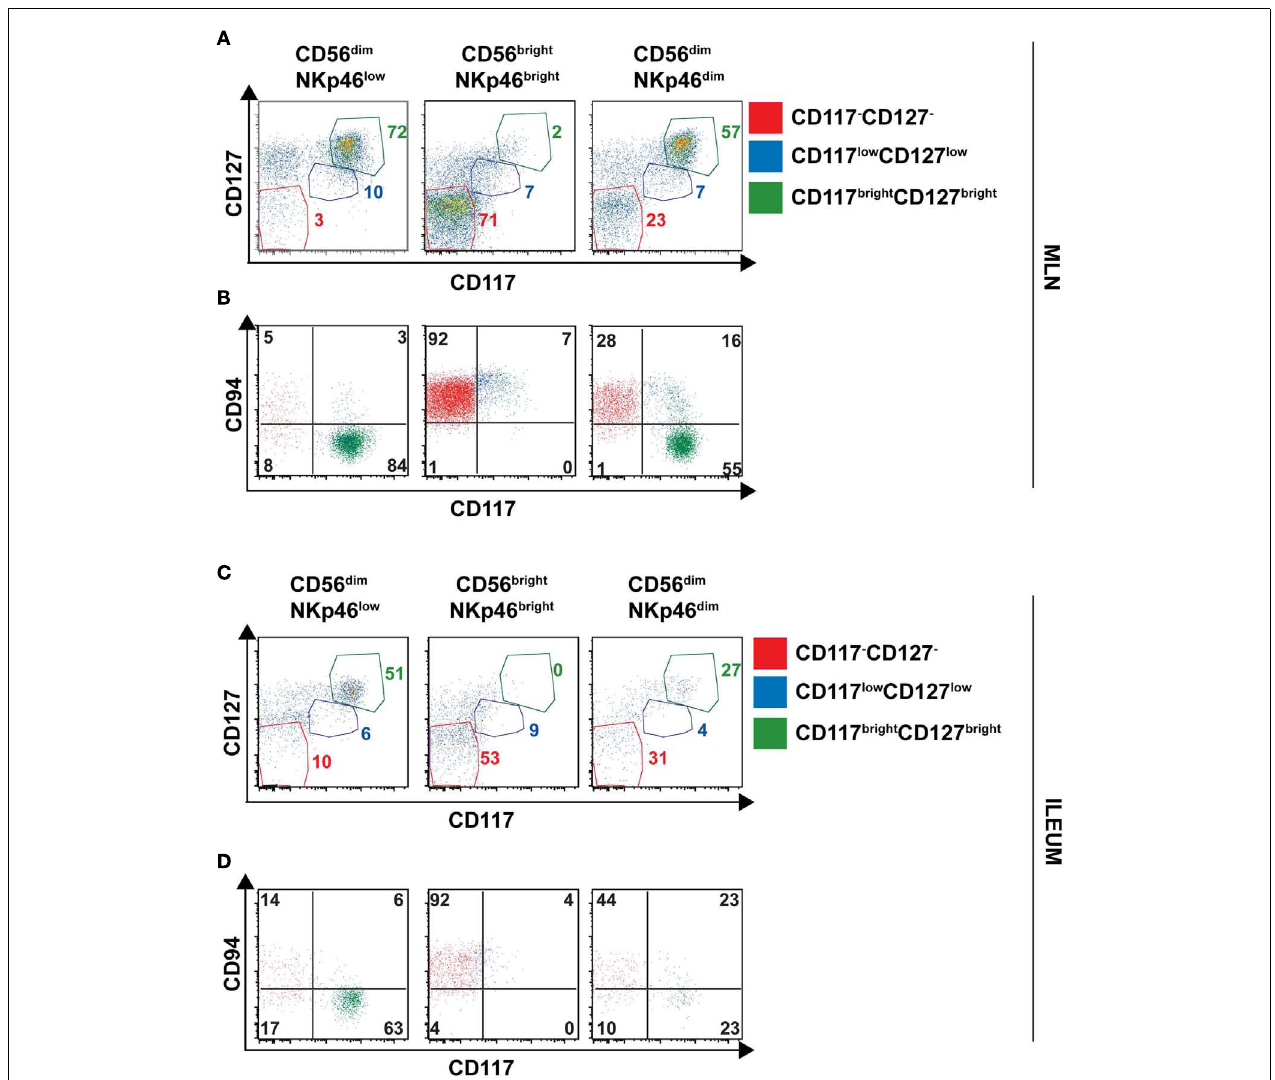
organs. Red gate, CD117 − CD127 − cells; blue gate, CD117 low CD127 low cells; green gate, CD117 bright CD127 bright cells. (A,B) , Mesenteric lymph node cells; (C,D) , Ileum